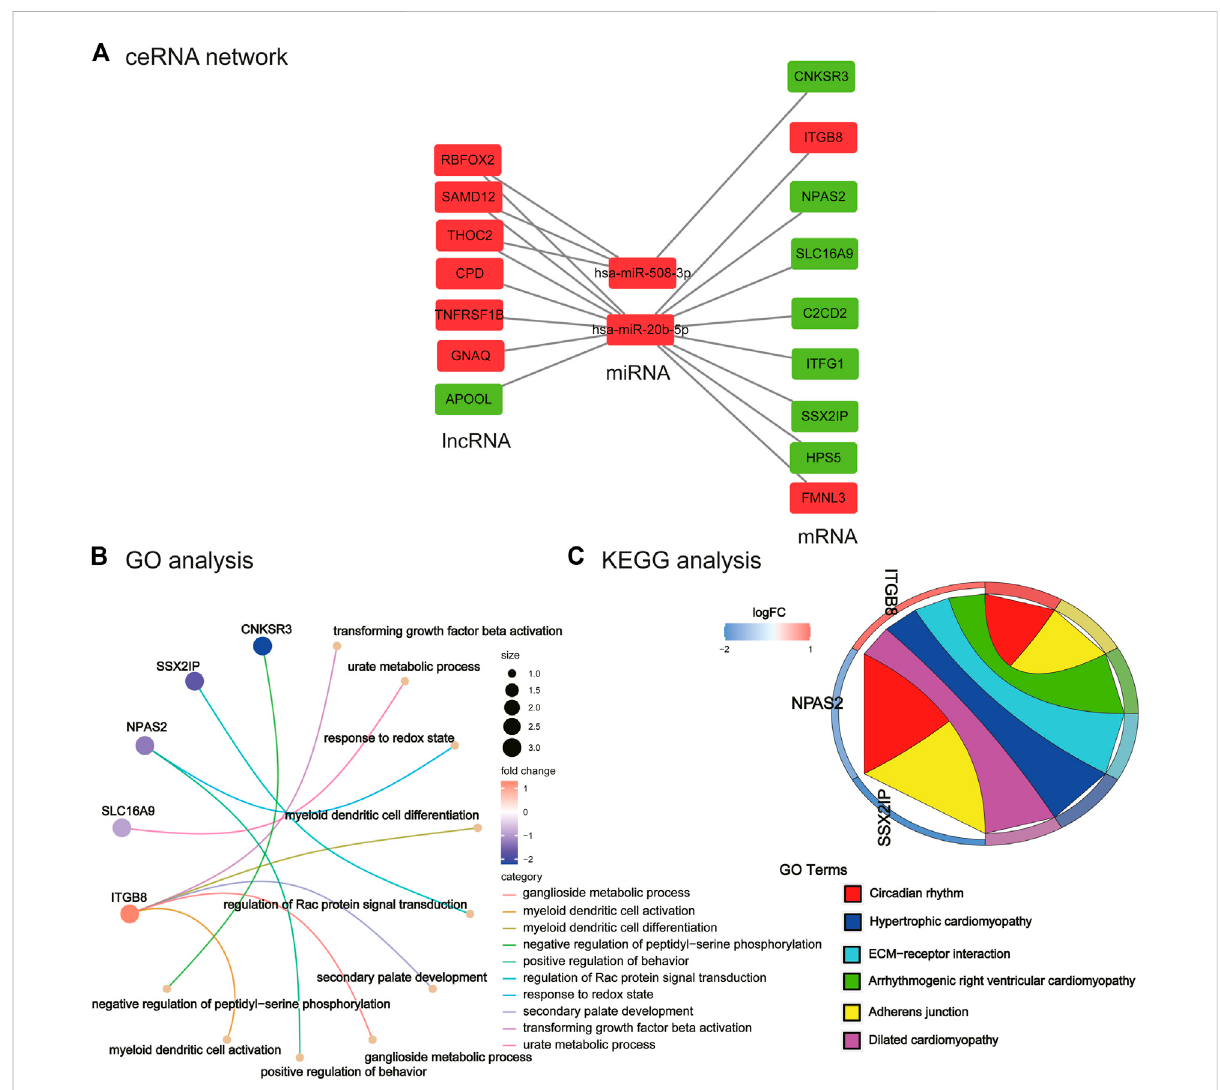
FIGURE 5 Construction of ceRNA network and its functional enrichment analysis. (A) ceRNA network. Red nodes represent upregulated lncRNA/miRNA/ mRNA in PCOS, and green nodes represent downregulated lncRNA/miRNA/mRNA genes in PCOS. (B) GO analysis of ceRNA network. (C) KEGG analysis of ceRNA